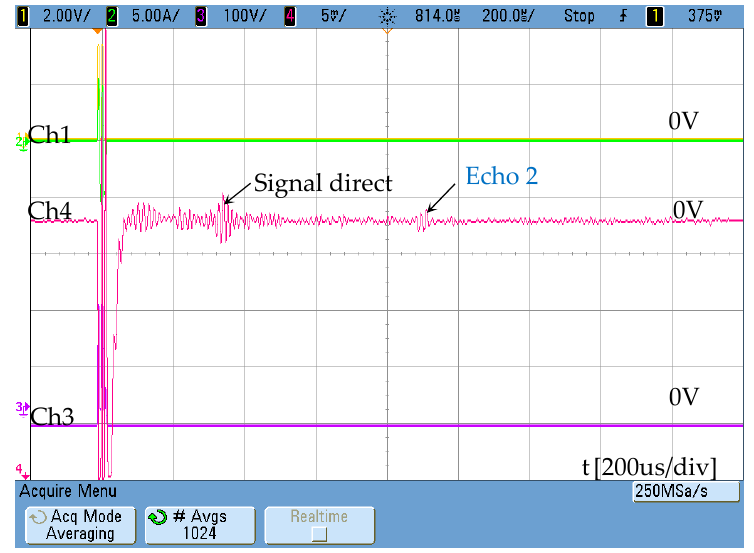
Figure 20. Signal obtained in the receiver configured according to the new magnetostrictive transducer using permanent magnets (Figure 10) Ch4: [5 mV/div]. Ch1 shows the activation signal of the power stage [2 V/div] and Ch3 the voltage at resonant circuit [100 V/div]. The maximum AC current is 5A.